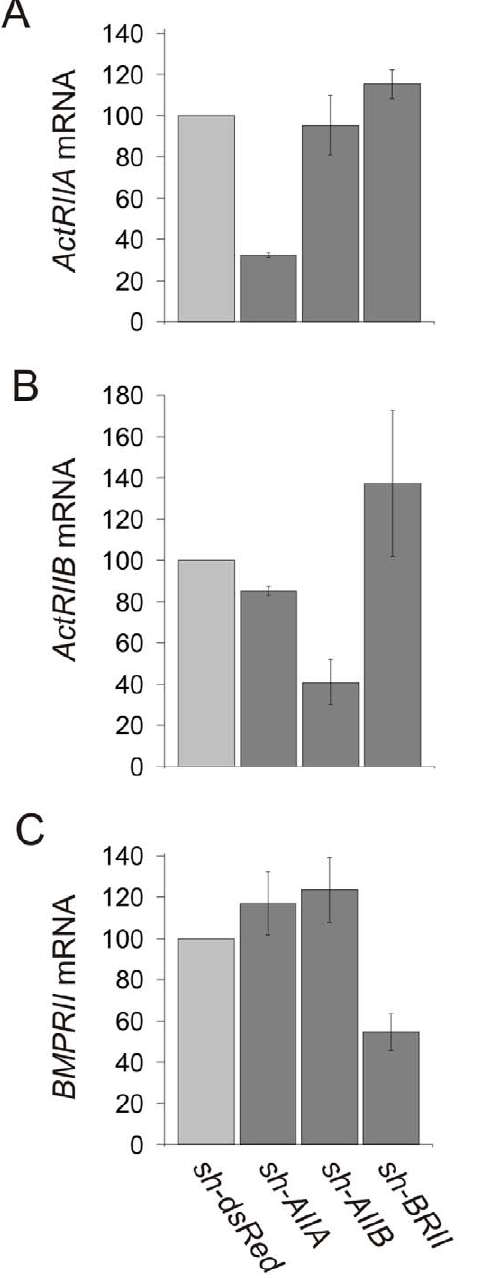
Figure 3. Knockdown of type II BMP receptors in WEHI 274.1 cells by receptor-targeted shRNAs. Real-time QPCR analysis of dsRed D 2 , ActRIIA D 2 , ActRIIB D 2 and BMPRII D WEHI cells. Results are expressed as the percent of control (mean + / 2 SEM) for each condition relative to BMP receptor mRNA levels in dsRed D WEHI (control) cells (n=2). A: ActRIIA mRNA expression in the presence of sh-AIIA (32% + / 2 1%), sh-AIIB (95% + / 2 14%) or sh-BRII (115% + / 2 7%). B: ActRIIB mRNA expression in the presence of sh-AIIA (85% + / 2 2%), sh-AIIB (41% + / 2 11%) or sh-BRII (137% + / 2 36%). C: BMPRII mRNA expression in the presence of sh-AIIA (117% + / 2 15%), sh-AIIB (124% + / 2 16%) or sh-BRII (55% + / 2 9%). Individual type II BMP receptor shRNAs modulated target mRNAs selectively, but had no significant effect on the expression level of non-target BMP receptor mRNA.